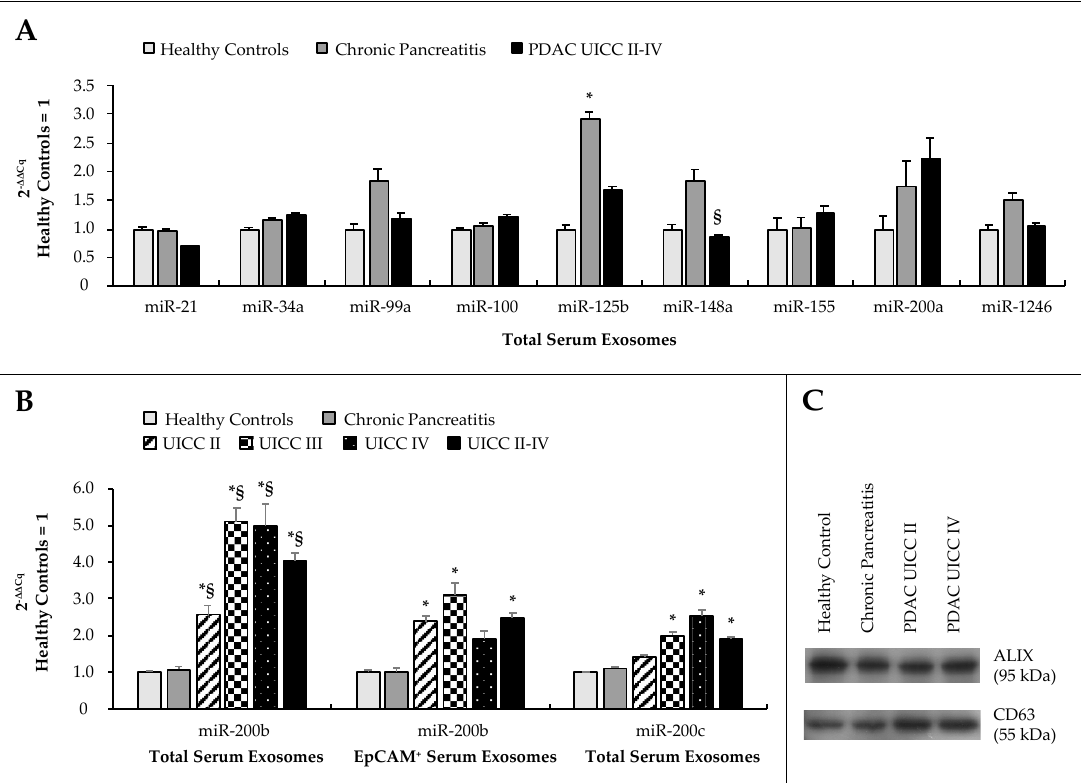
Figure 1. ( A ) Expression of a panel of miRs in circulating serum exosomes and ( B ) expression of miR-200b in total and EpCAM (epithelial cell adhesion molecule)-positive serum exosomes and of miR-200c in total serum exosomes. Data were analyzed by RT-qRT-PCR and plotted as 2 −ΔΔ Cq ± standard error of the mean (SEM), relative to healthy controls. Statistical significance ( p ≤ 0.05, Kruskal–Wallis test) is indicated relative to healthy controls (*) and chronic pancreatitis (§). ( C ) Western blot for exosomal markers ALIX (apoptosis-linked gene 2—interacting protein X) and CD63 (cluster of differentiation 63) in exosomes isolated from patients’ blood serum specimens.